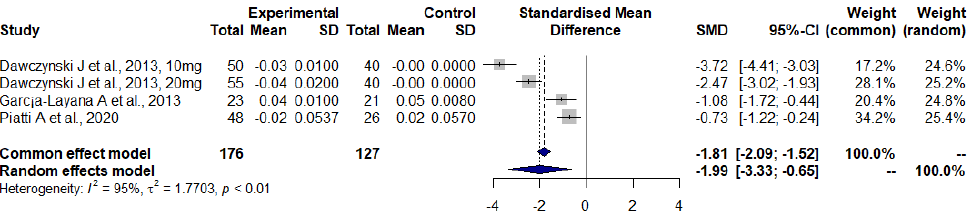
Figure 5. Forest plot of BCVA in studies with lutein and zeaxanthin combined with n -3 LC-PUFA; SD, standard deviation; SMD, standardized mean difference; CI, confidence interval n-3 LC-PUFA (DHA and EPA) [26,29,39] .